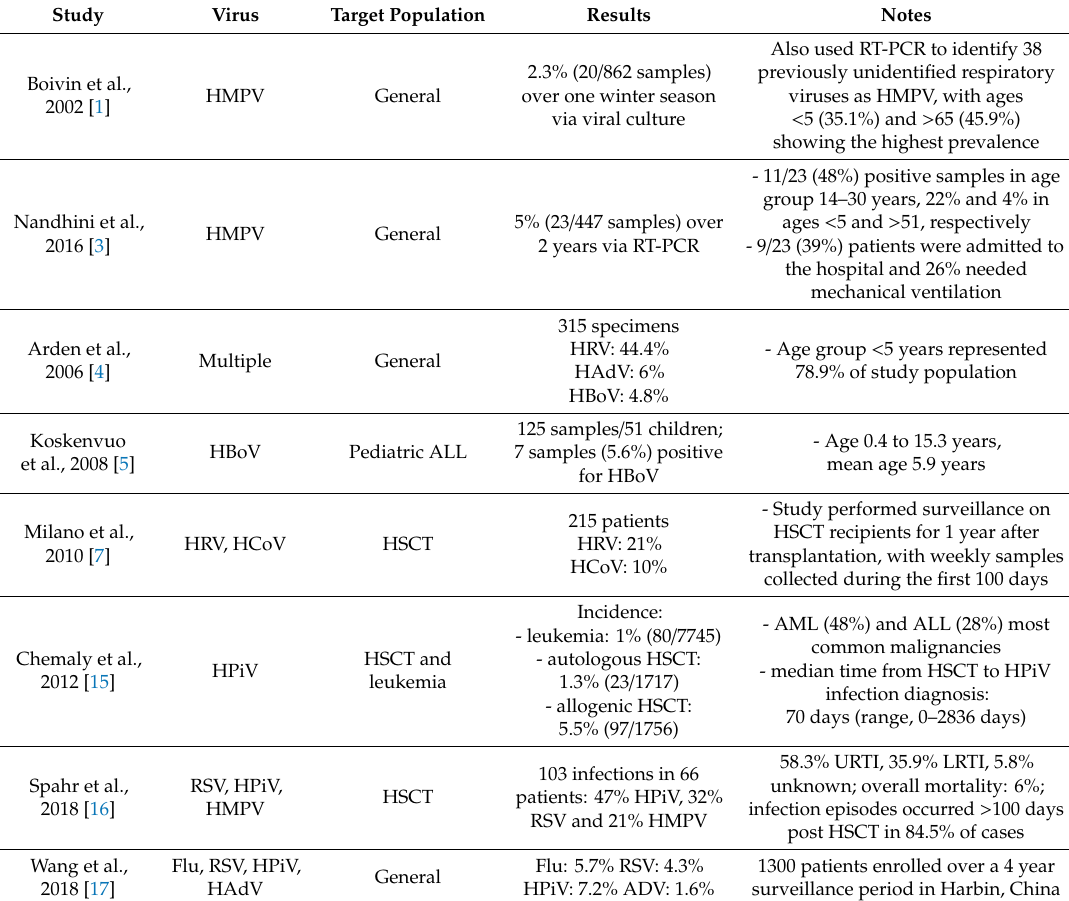
Table 1. Epidemiology of some common respiratory viruses.